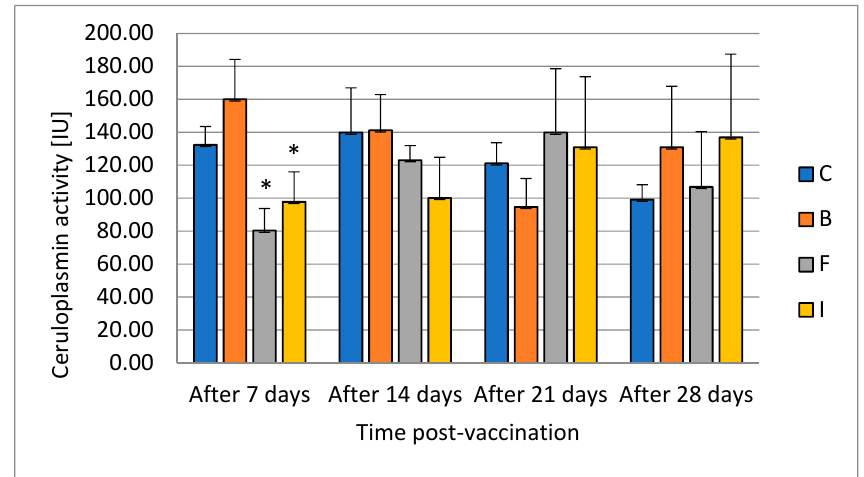
Figure 2. The effects of various routes of vaccination against A. salmonicida on ceruloplasmin activity in pikeperch serum (mean value ± SD, n = 9, * statistical significance p ≤ 0.05).